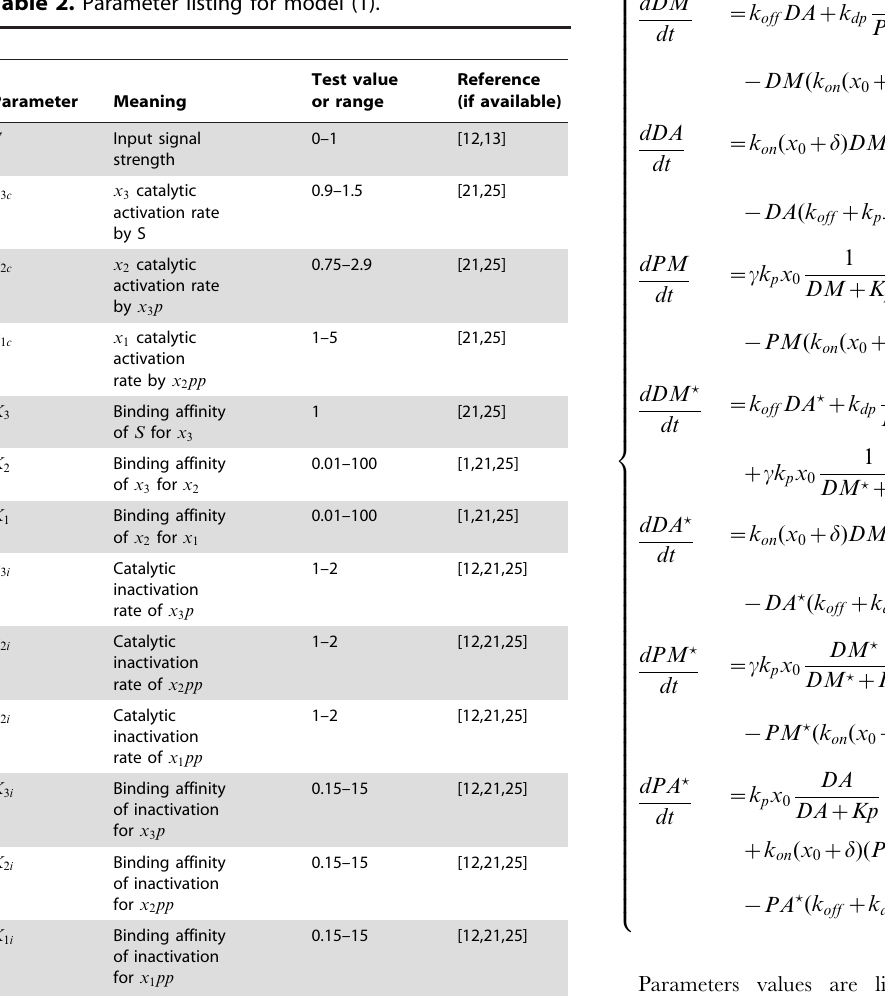
Table 2. Parameter listing for model